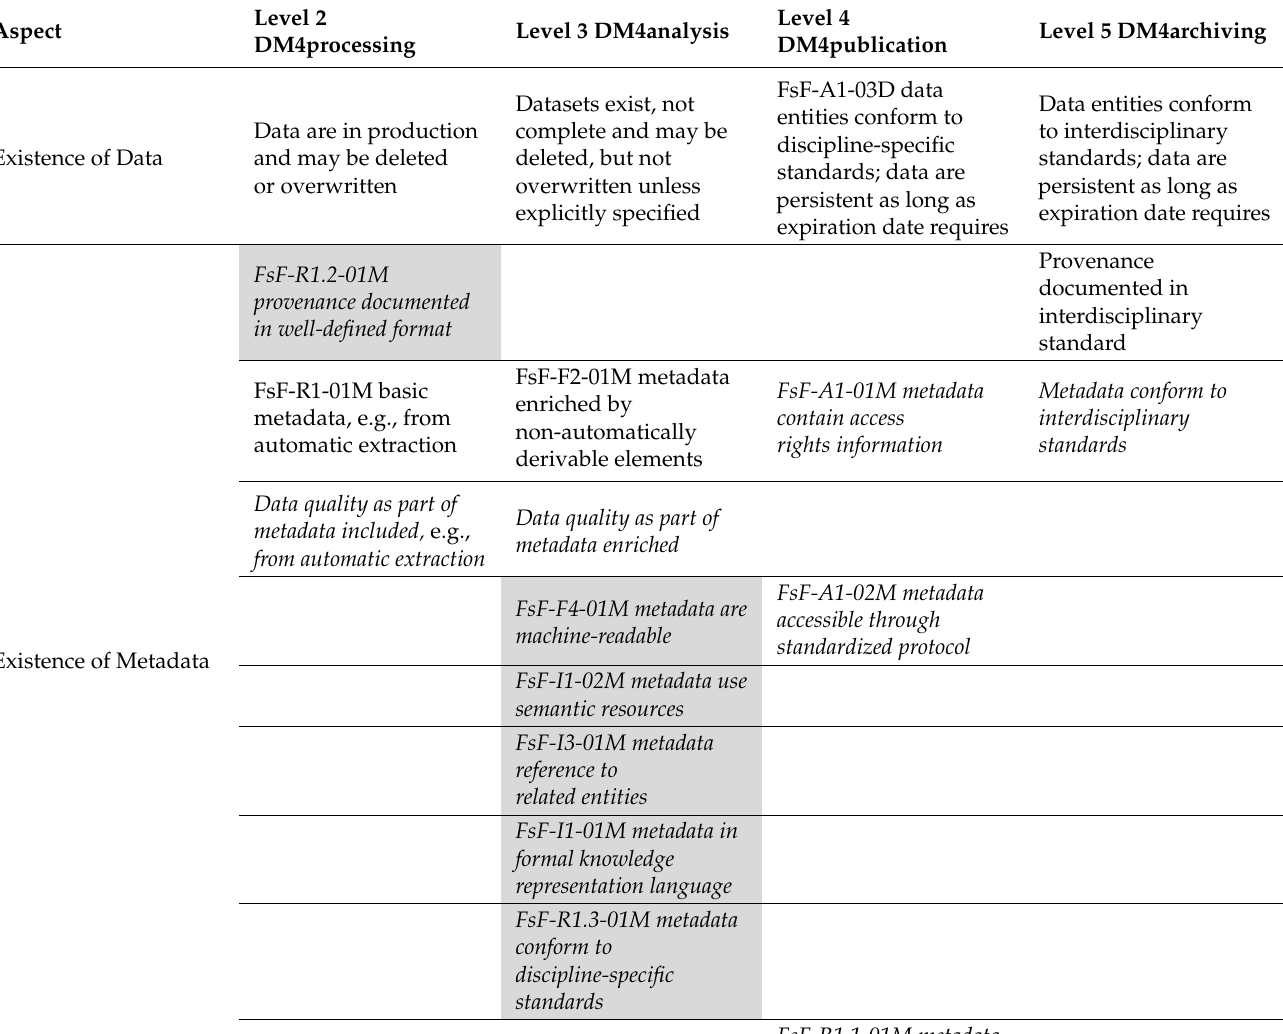
Table 5. Maturity matrix for the criterion integrity. Italic text marks changed or added metrics. Gray background marks level changes from original QMM. Removed measures from [34] are not listed in the